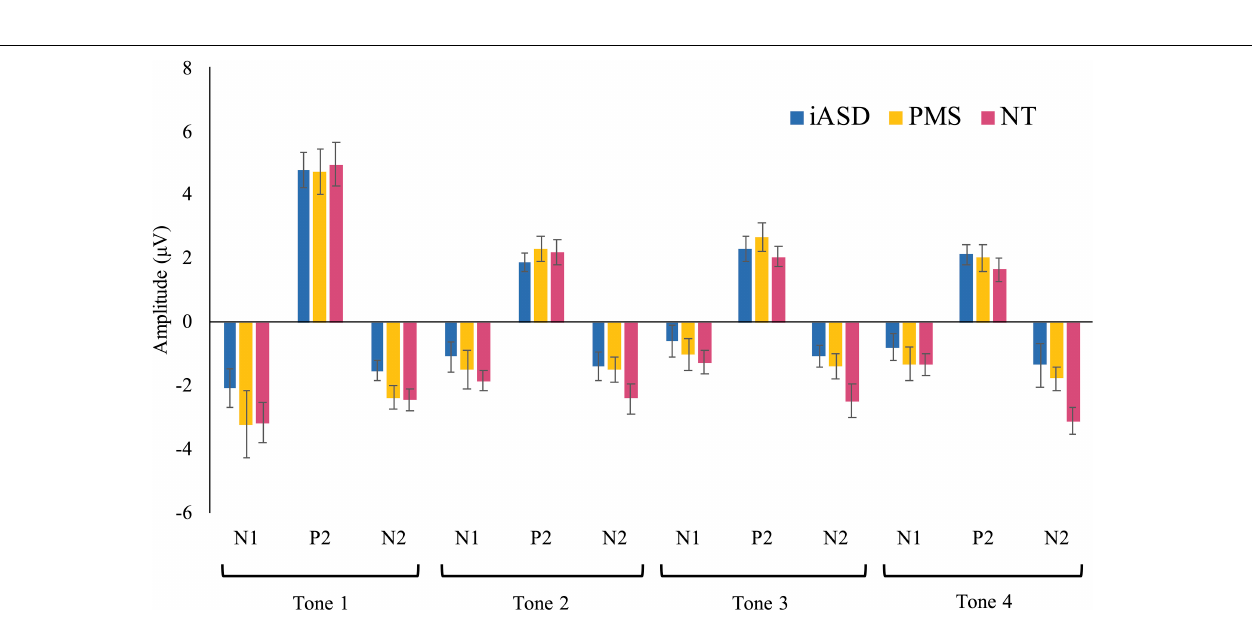
FIGURE 2 | Means of each ERP component in response to tones 1–4 with standard error bars in iASD, PMS, and NT groups.